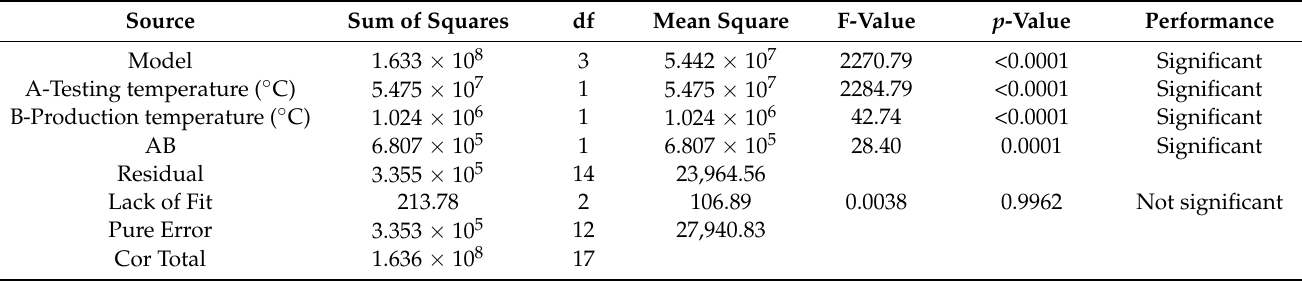
Table 6. ANOVA for the 2FI model.